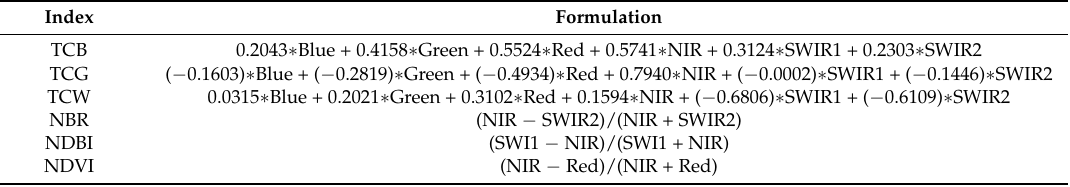
Table 4. Calculation of time series